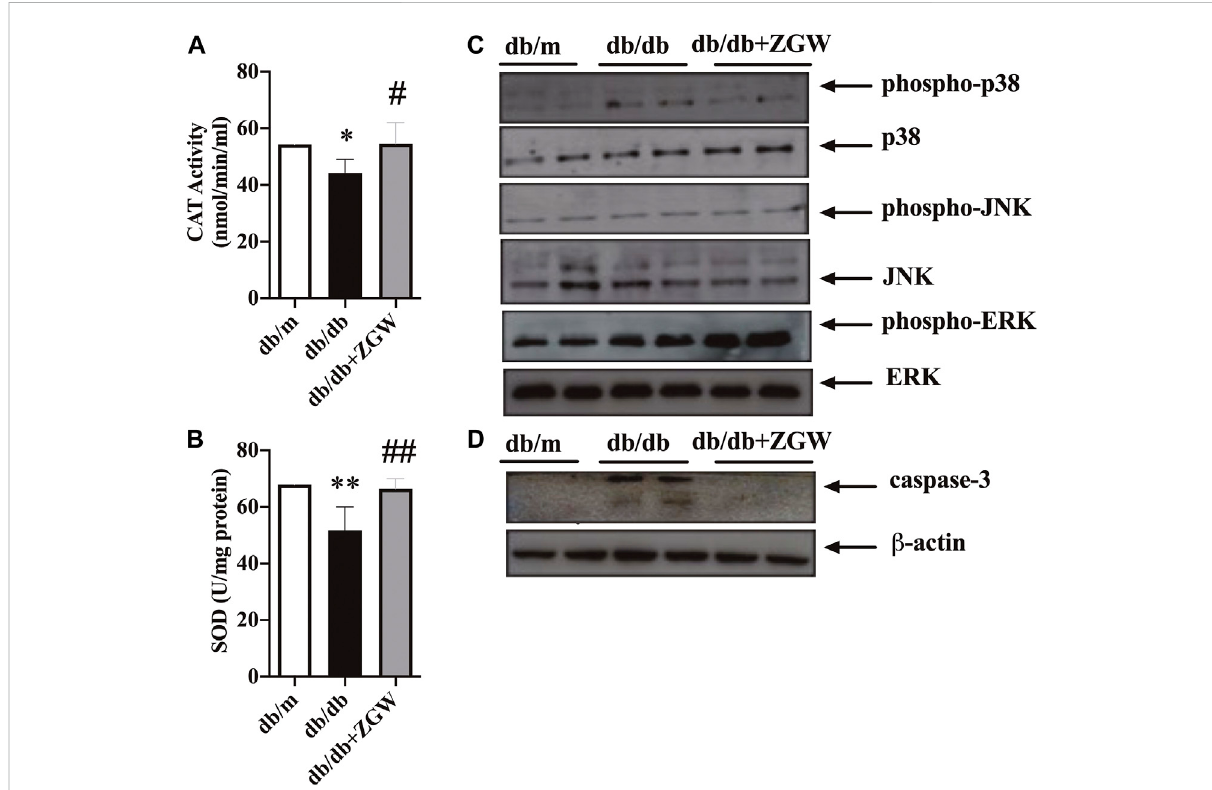
FIGURE 4 ZGW elevatedactivitiesof CAT and SOD, inhibited caspase-3, and regulatedp38/MAPK signaling in db/db mice. The effects of ZGW on (A) CAT and (B) SOD were detected by ELISA. Representative immunoblots of MAPK signaling (C) and cleaved caspase-3 (D) . Statistical analysis was performed with one-way ANOVA and an unpaired t test. ** p < 0.05, ** p < 0.01, compared with db/m mice. # p < 0.05, ## p < 0.01 compared with db/ db